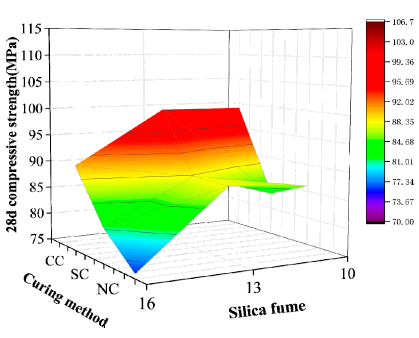
Figure 4. Water/binder ratio.